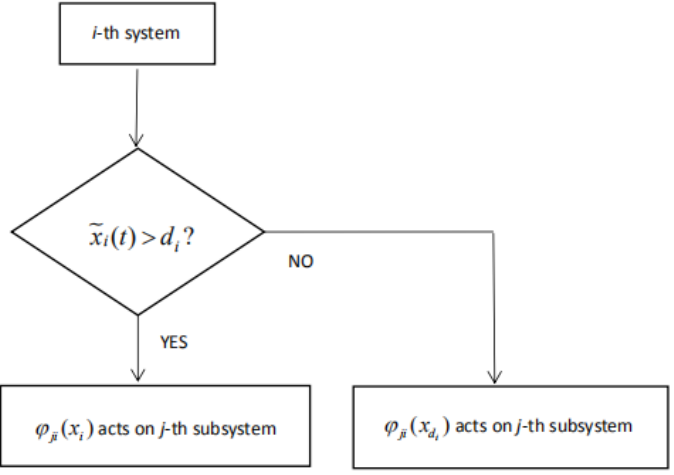
Figure 2. Subsystem communication protocol.